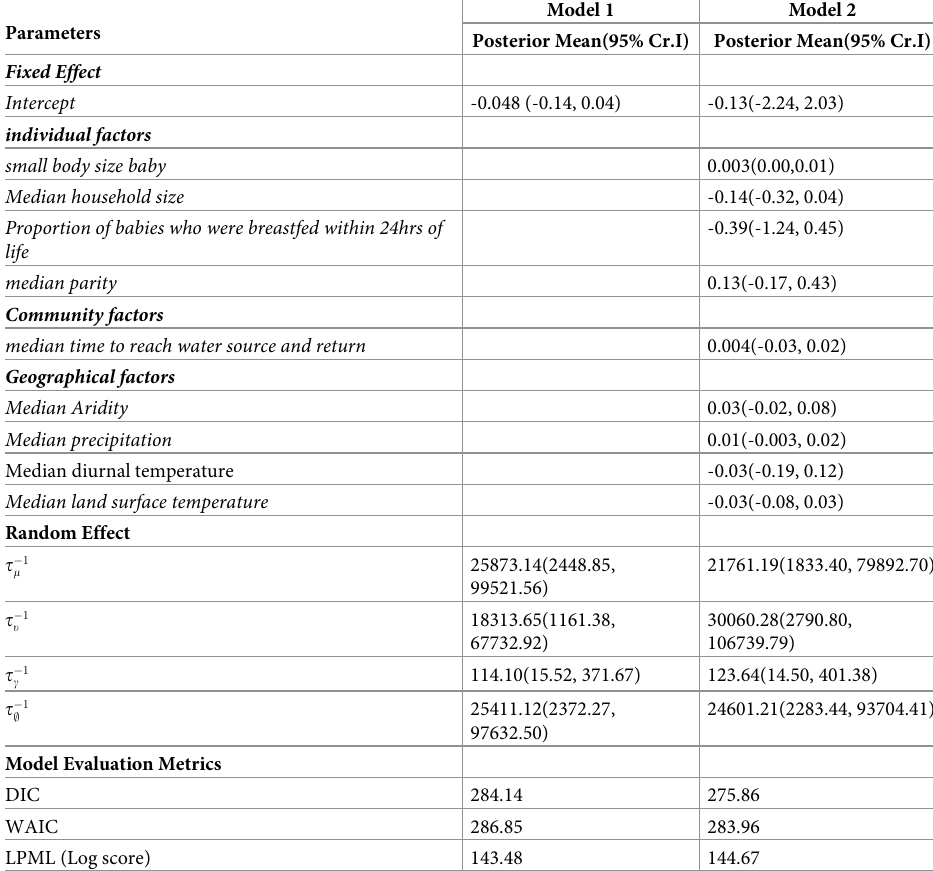
Table 5. Summary of posterior means and Bayesian credible intervals of smooth relative risk of neonatal mortal- ity estimated from weighted Bayesian Hierarchical Spatiotemporal model with and without covariates using aggregated 1993–2014 Ghana demographic and health survey (GDHS) regional level data.